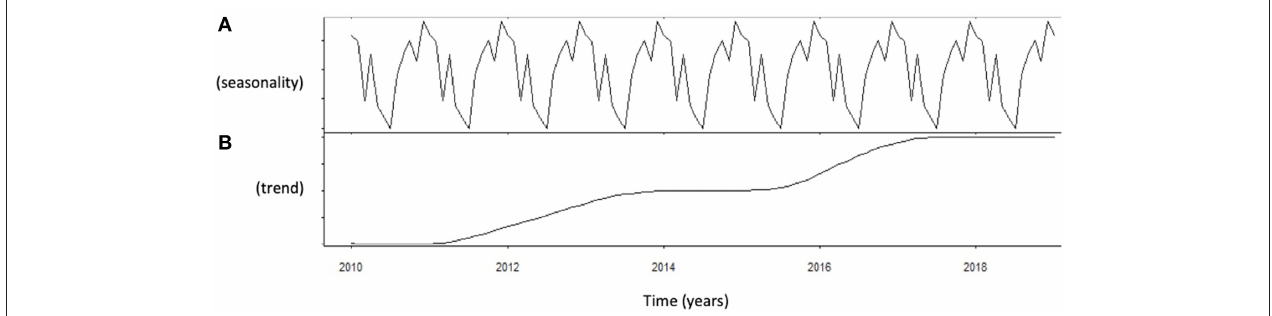
FIGURE 1 | Analysis of serum testosterone level distribution using autoregressive integrated moving average (ARIMA) model. (A) Shows the data distribution across years, suggesting possible peak and nadir. (B) Shows the trend of data collected across years of observation.